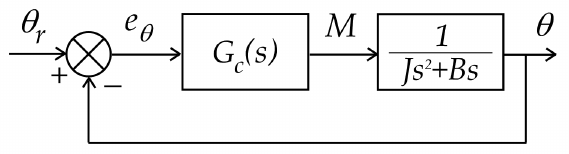
Figure 1. Closed-loop system with a second-order plant.